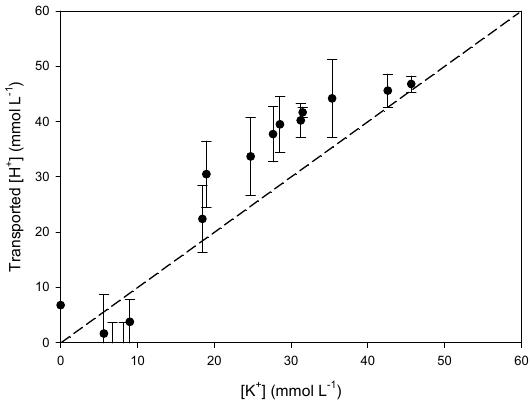
Figure 9. Comparison of the transported [H + ] into the feed phase and [K + ] in the receiving phase using PIM-8.